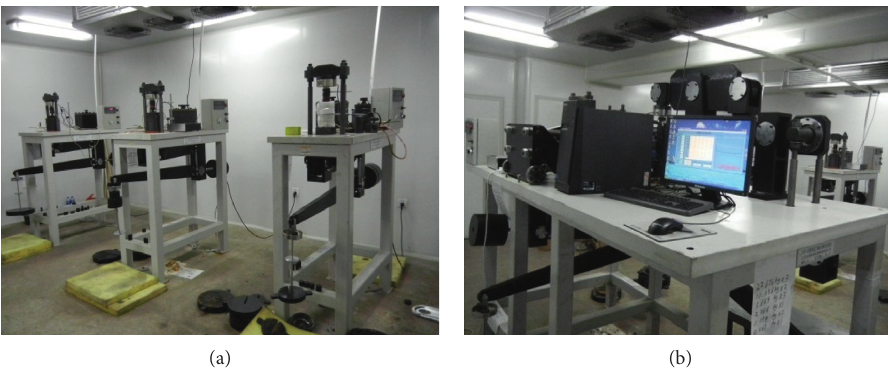
Figure 2: Uniaxial creep testing machine: (a) YDY-100 high-temperature uniaxial rock creep tester and (b) stress and displacement acquisition system.